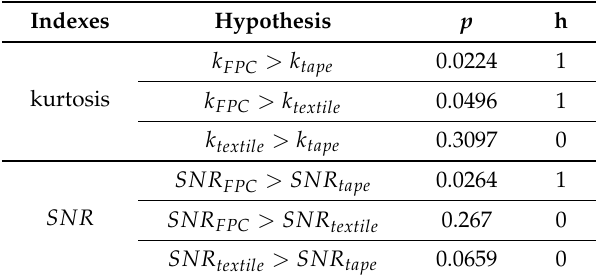
Table 5. Significant t -test of signal quality indexes of three materials (alpha = 0.05).